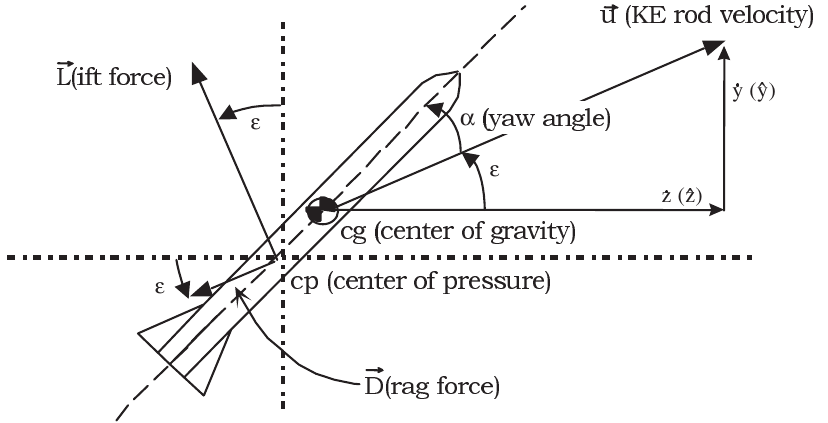
Fig. 12. Illustration of 2-D planar force and velocity